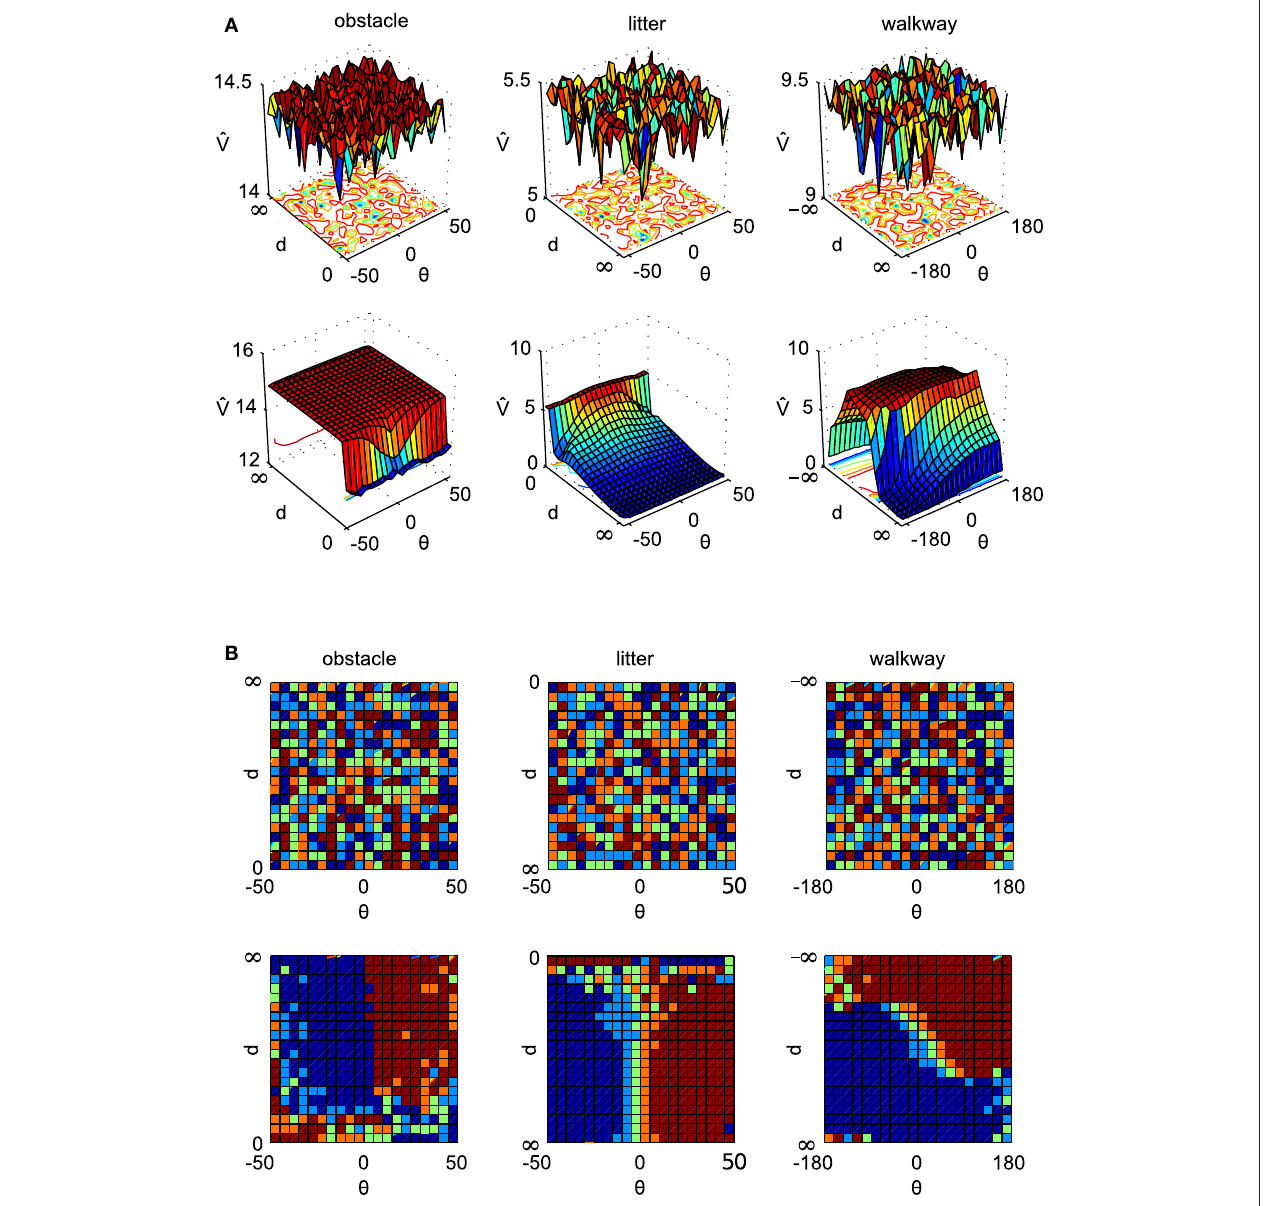
Figure 9 | representations of value functions and policies in the walkway navigation task for the three component behaviors. (A) Top row: initial value function estimates Vˆ(s). Bottom row: final value estimates. (B) Representations of policies. Top row: initial policy estimates π ˆ(s). Bottom row: final policy estimates. The navigation actions are coded as follows: left turns are red, straight ahead is light green, right turns are